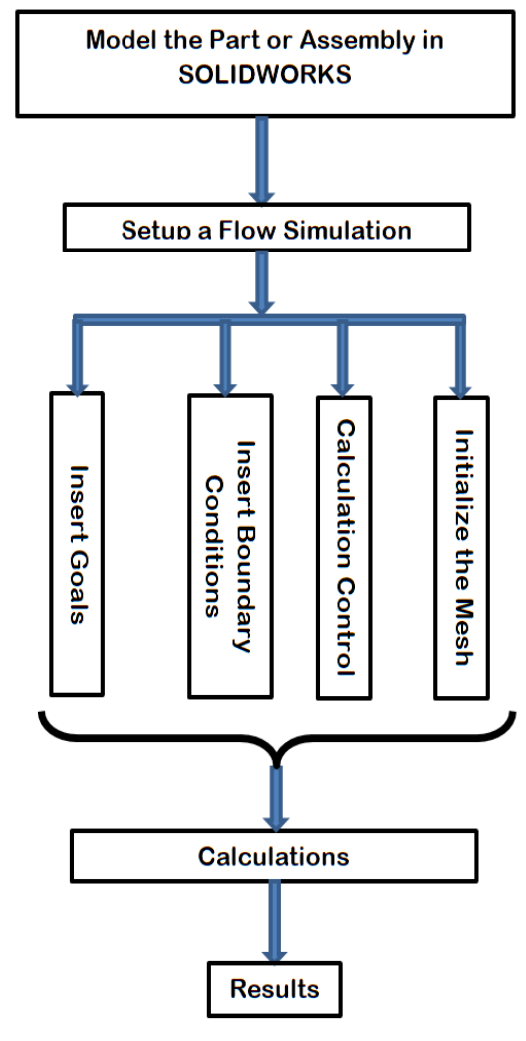
Figure 1. SolidWorks Flow Simulation (SWFS) flowchart.